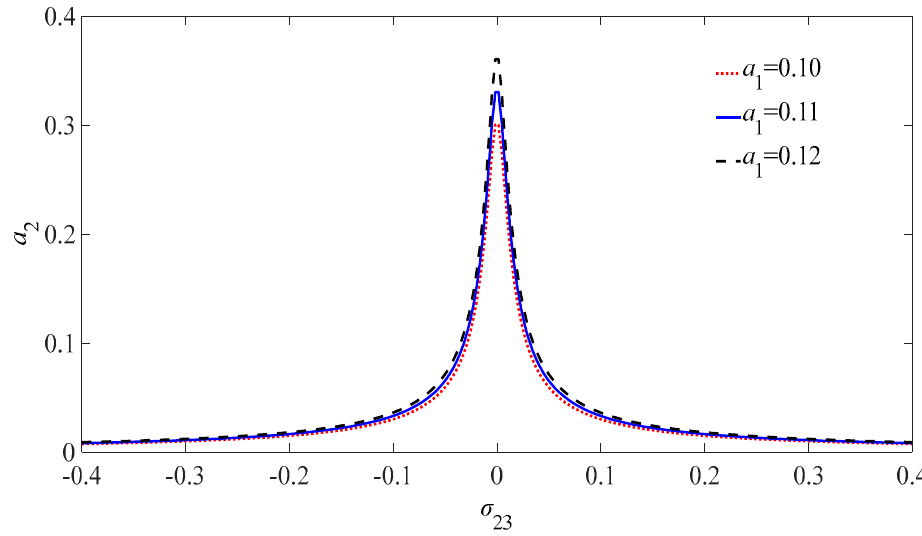
The amplitude of the solution of the equation increases with the increasing of ampli- tudes of PDJJ. Figure 3. Internal resonant amplitude-frequency diagram of the circuit charge for different PDJJ.